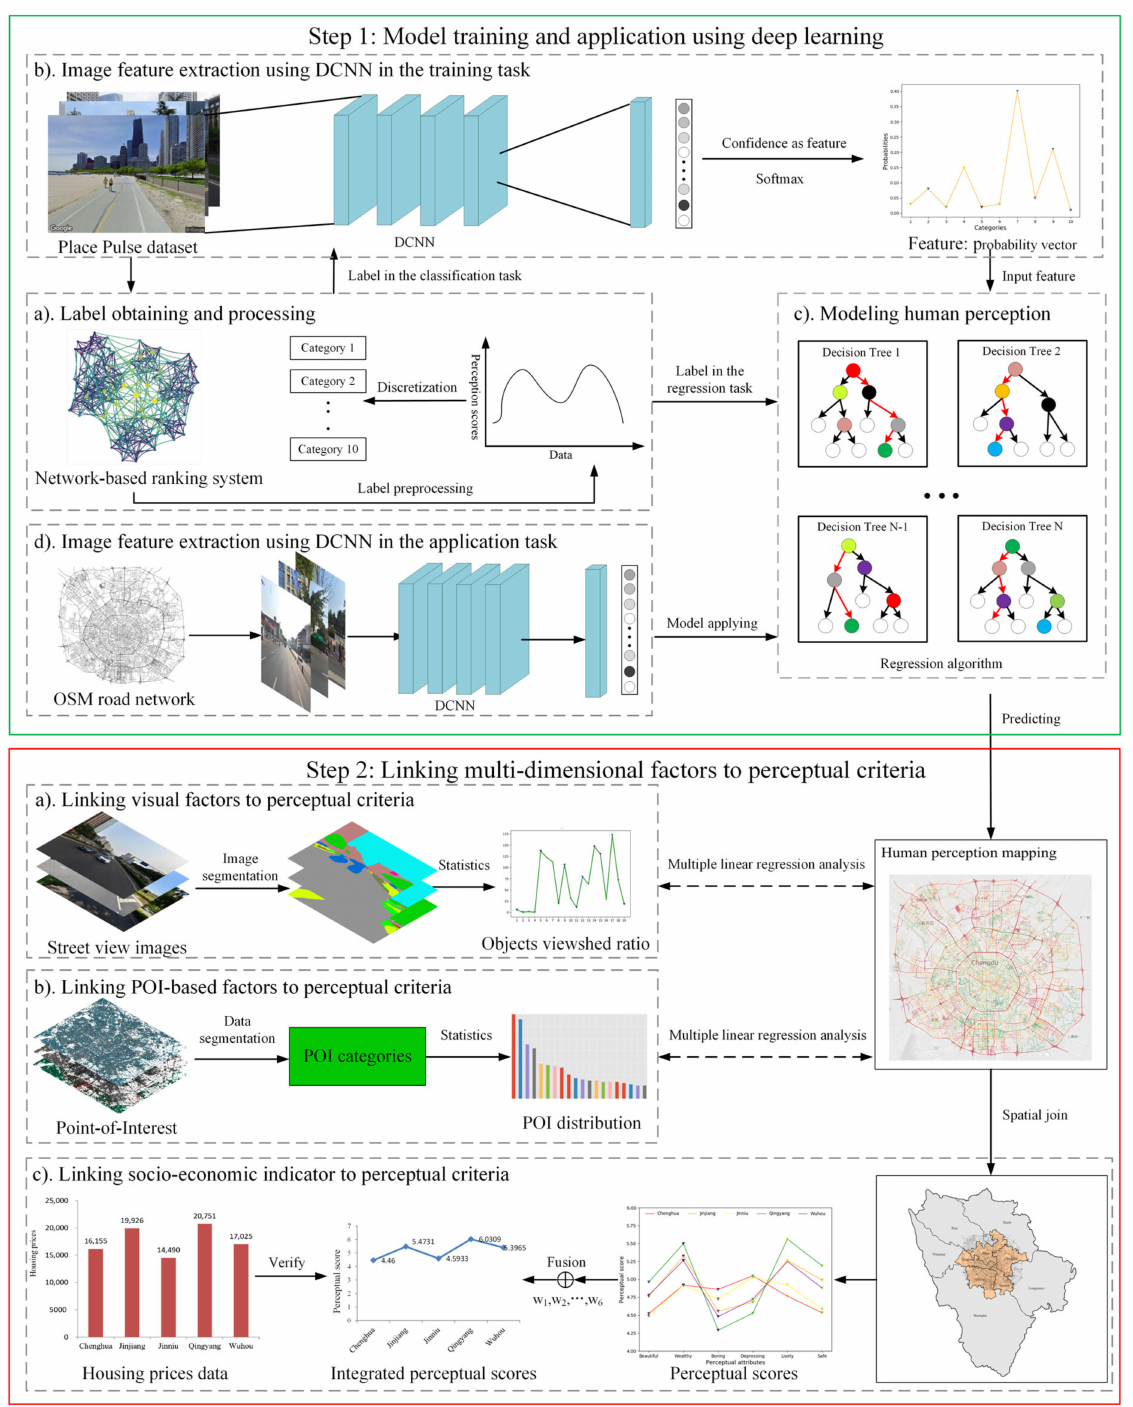
Figure 2. The proposed data-enabled intelligence framework for measuring and analyzing human perception of urban